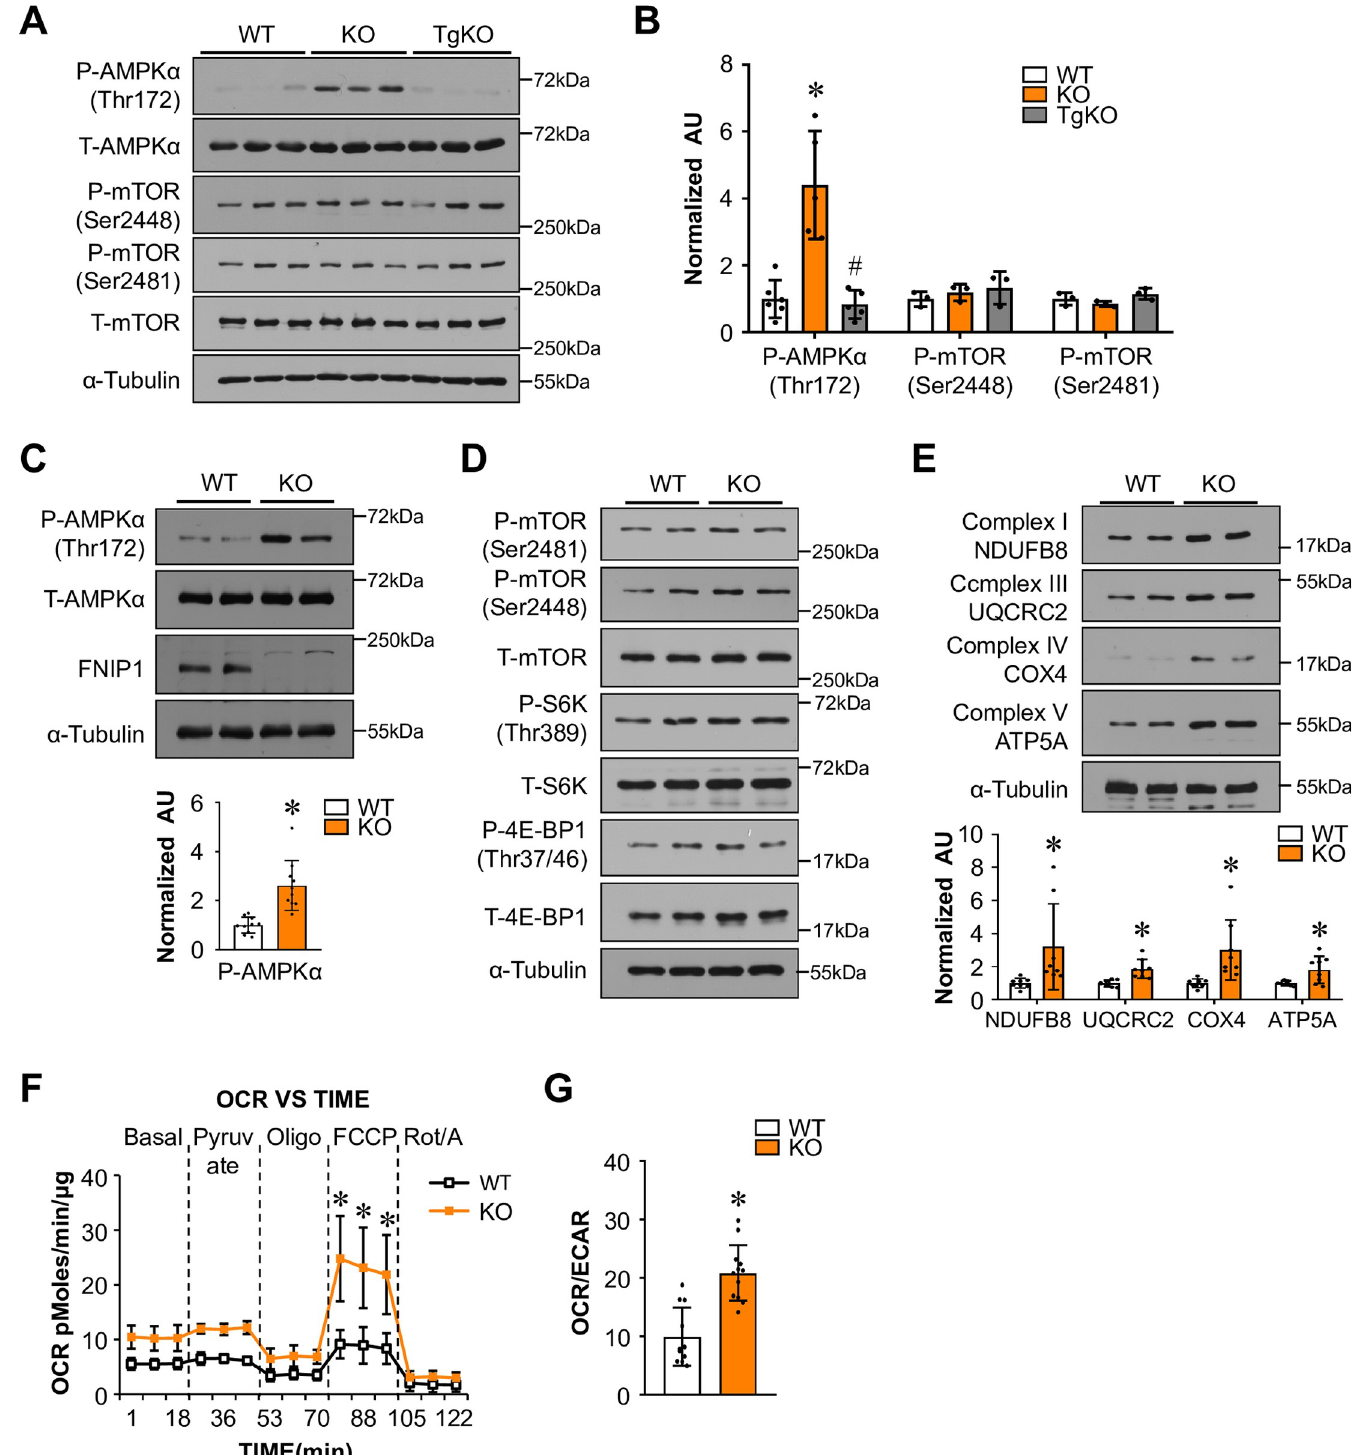
Fig 3. FNIP1 inhibits muscle AMPK pathway and mitochondrial oxidative program in a cell-autonomous manner. ( A ) Representative immunoblot analysis of WV muscle lysates for mice of the indicated genotype using the indicated antibodies. ( B ) Quantification of the p-AMPK α (Thr172)/AMPK α , p-mTOR (Ser2448)/mTOR, p- mTOR (Ser2481)/mTOR signal ratios were normalized (= 1.0) to the WT controls. n = 3–6 mice per group. ( C-E ) Primary skeletal muscle myoblasts were isolated from GC muscles of Fnip1 KO and WT mice, and then induced to differentiation for 3 days. ( C ) Immunoblot analysis of myotube extracts using the indicated antibodies.